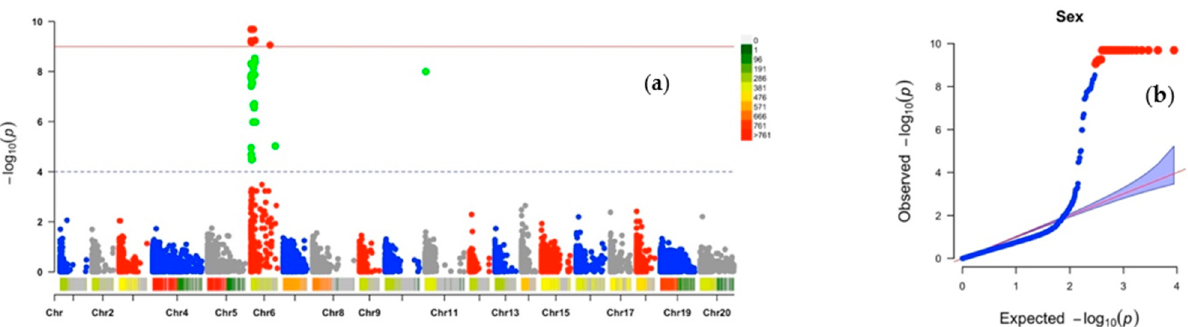
Figure 1. Genome-wide association analysis for plant sex determination in D. alata : ( a ) Manhattan plot, ( b ) quantile–quantile (Q–Q) plot. Vertical bars relate to the 20 yam chromosomes, green and red dots indicate chromosomes with influence on the target trait.